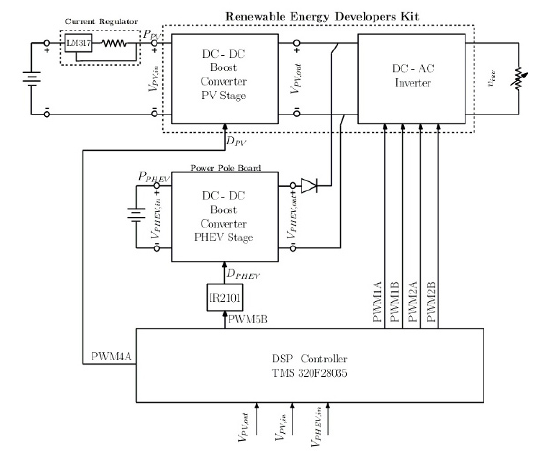
Figure 10. Block diagram for experimental